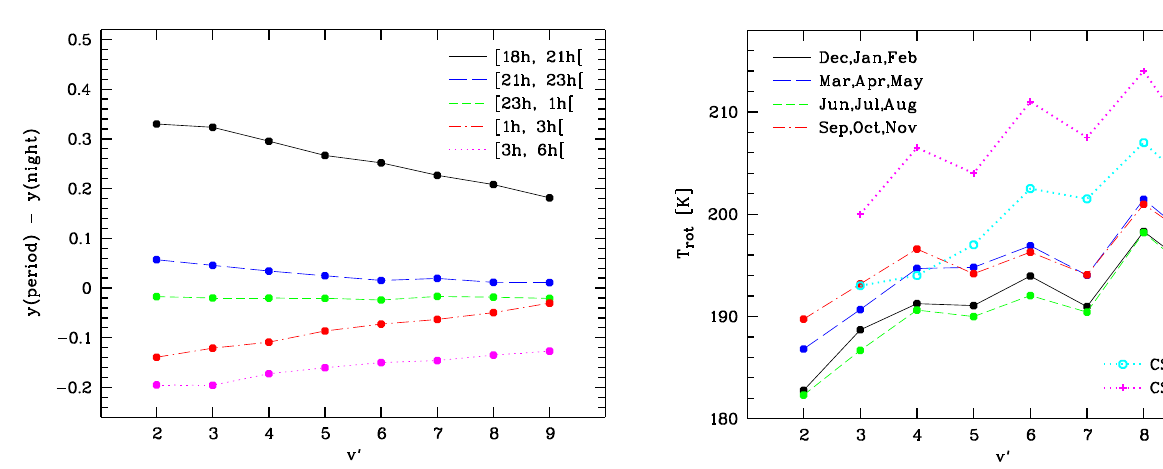
Figure 12. Rotational temperature T rot (v (cid:48) ) as a function of v (cid:48) for different meteorological seasons. The plot details are similar to those of Fig. 9. In addition, we show the Mauna Kea (19.8 ◦ N) mean T rot (v (cid:48) ) for March and October 2000 by Cosby and Slanger (2007). v (cid:48) , in accordance with the discussion in Cosby and Slanger (2007). Since the plotted curves are close to straight lines, the high v (cid:48) characterised by an overpopulation relative to the lower v (cid:48) (see Sect. 4.3) do not appear to show a special be- haviour. The v (cid:48) -dependent changes in the level populations of all v (cid:48) can be well described by T vib (2-9) differences. The re- sulting (cid:49)T vib (2-9) for the fourth (maximum of 10 030 K)